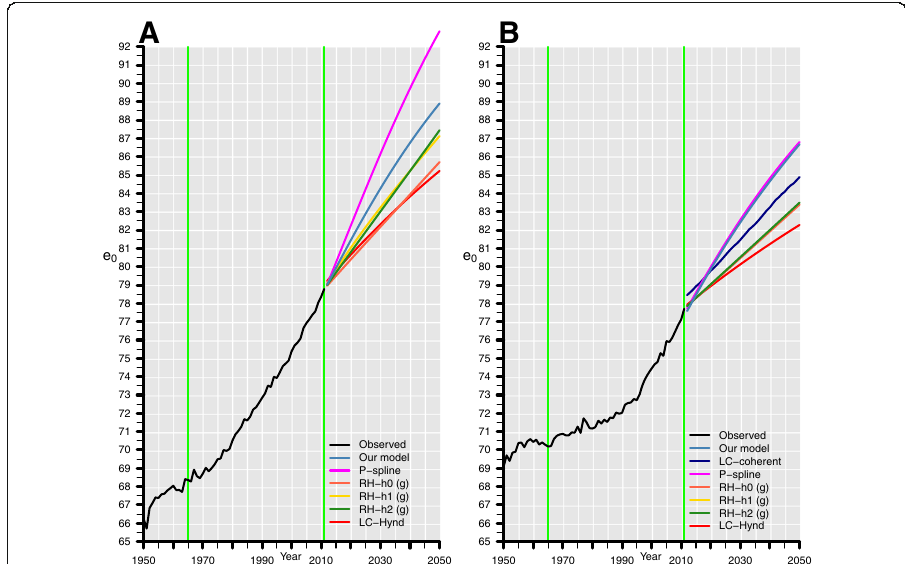
Fig. 12 Prospective forecasts of life expectancy at birth for British ( left ) and Danish ( right ) men of the proposed model ( blue ), the P-spline approach ( magenta ), the LC model ( red ), and four of its variants: h0 ( light red ), h1 ( yellow ), h2 ( green ), and coherent ( navy blue ). Observed data are depicted in black . In the Danish forecast, the proposed model and the coherent LC model use data from Sweden, France, Italy, and